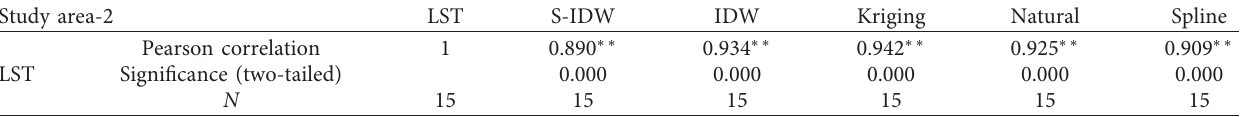
Table 14: Correlation analysis of interpolation results of 5 kinds of interpolation methods on Feb. 11, 2017.